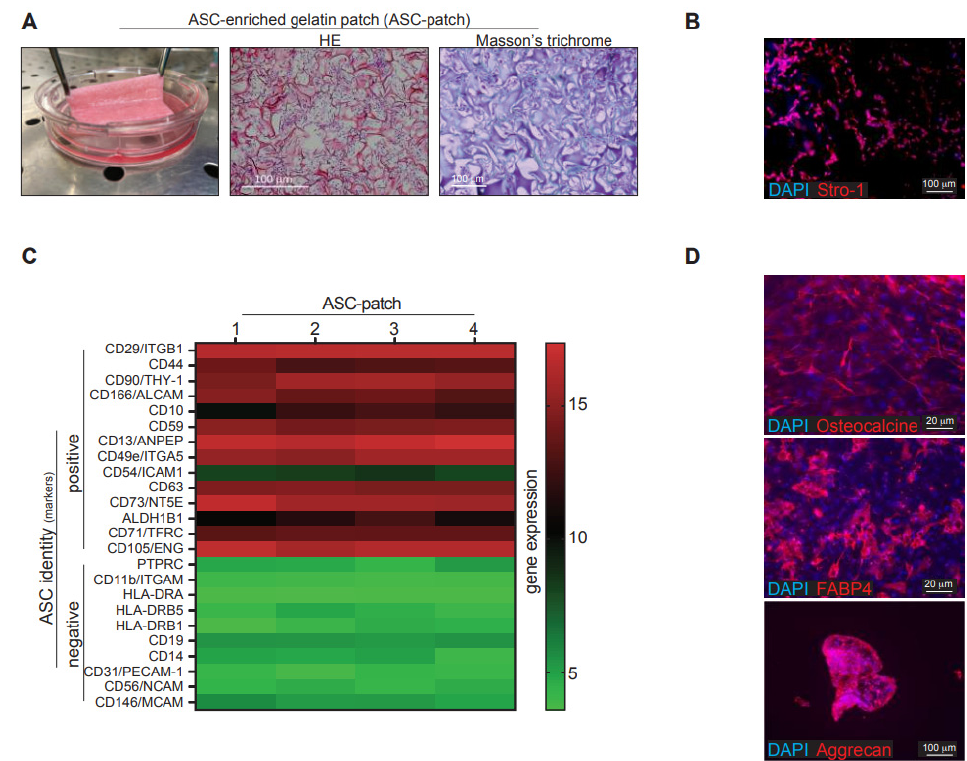
Figure 1. ASC cultured within a gelatin sponge generates a stable and easy-handling cellular patch (ASC-patch). ( A ) Macroscopic image of an ASC-patch (left). Hemalum/eosin coloration (middle) and Masson-trichrome staining (right) of an ASC-patch are shown. ( B ) Immunofluorescence staining of an ASC-patch section for the stromal marker Stro-1. ( C ) Full gene expression array of ASC- patches generated from 4 independent ischemic patients. Commonly used positive markers for ASC identification are shown. ( D ) Differentiated towards osteoblasts, adipocytes or chondrocytes of ASCs extracted from the ASC-patches. Osteocalcin (osteoblasts), FABP4 (adipocytes) and aggrecan (chondrocytes) staining are